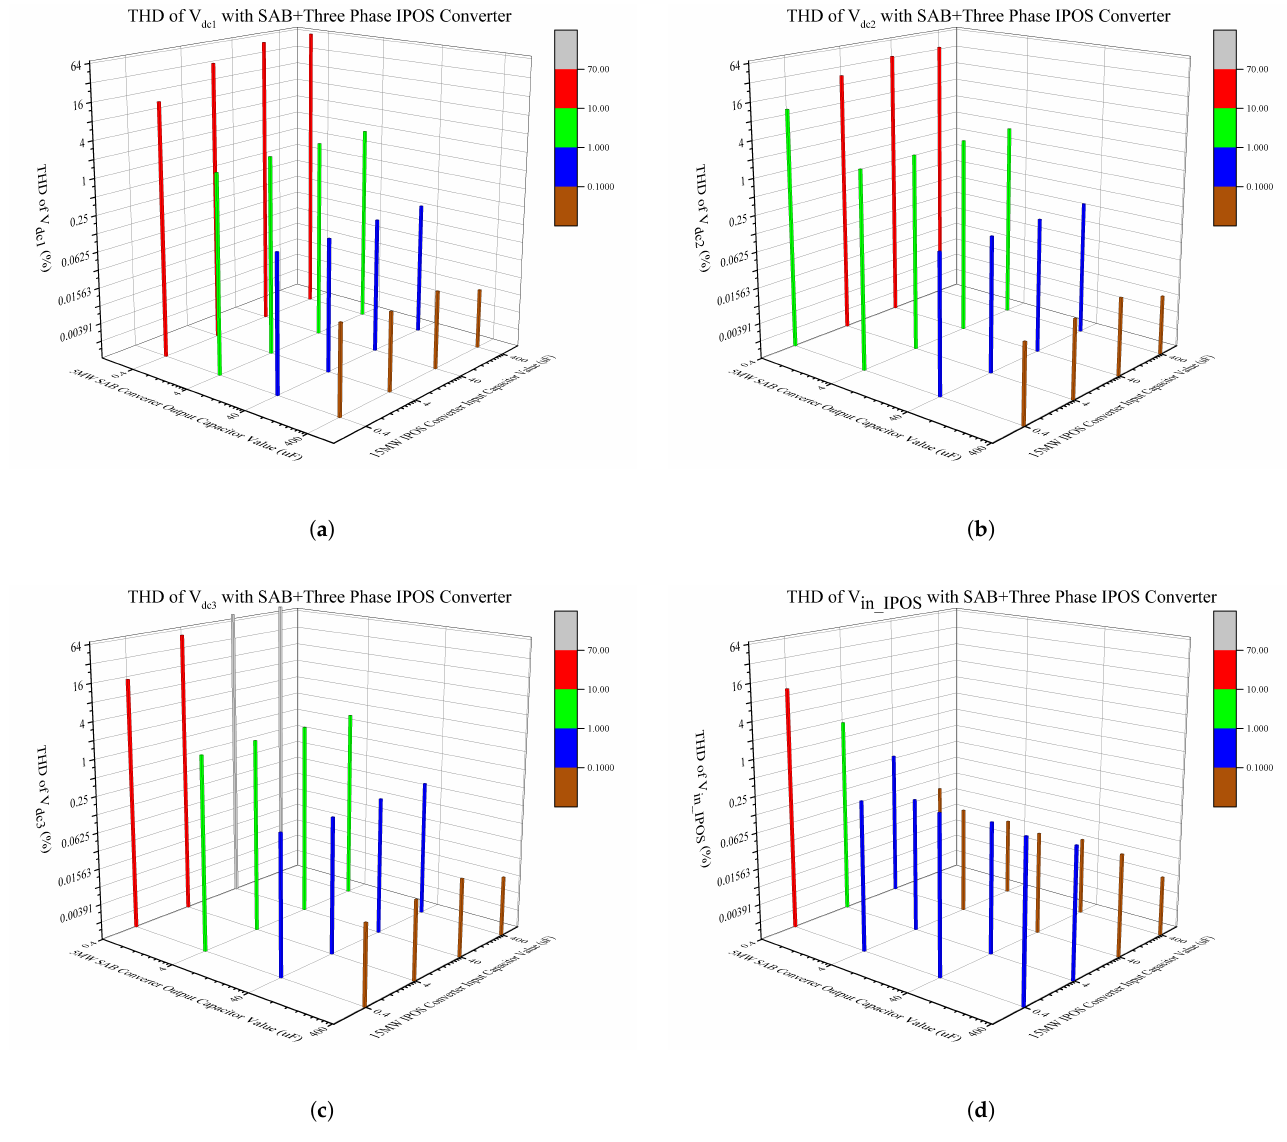
Figure 5. Total harmonic distortions of terminal voltages in Figure 2 in different filter capacitor values with SAB + Three Phase IPOS Converter. ( a ) Total harmonic distortions V dc1 ; ( b ) total harmonic distortions V dc2 ; ( c ) total harmonic distortions V dc3 ; and ( d ) total harmonic distortions V in_IPOS